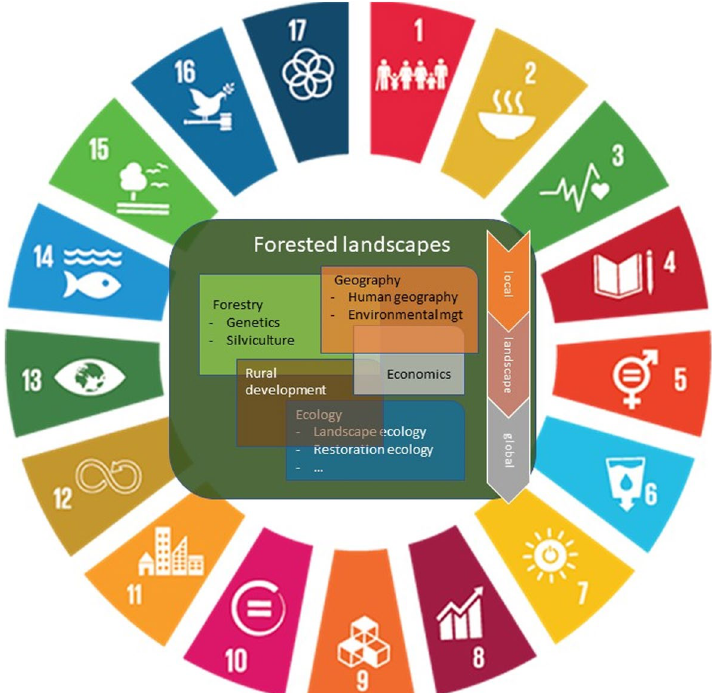
Fig. 1 Forested landscapes as multidisciplinary spaces contributing to all 17 Sustainable Development Goals (modified from Mansourian